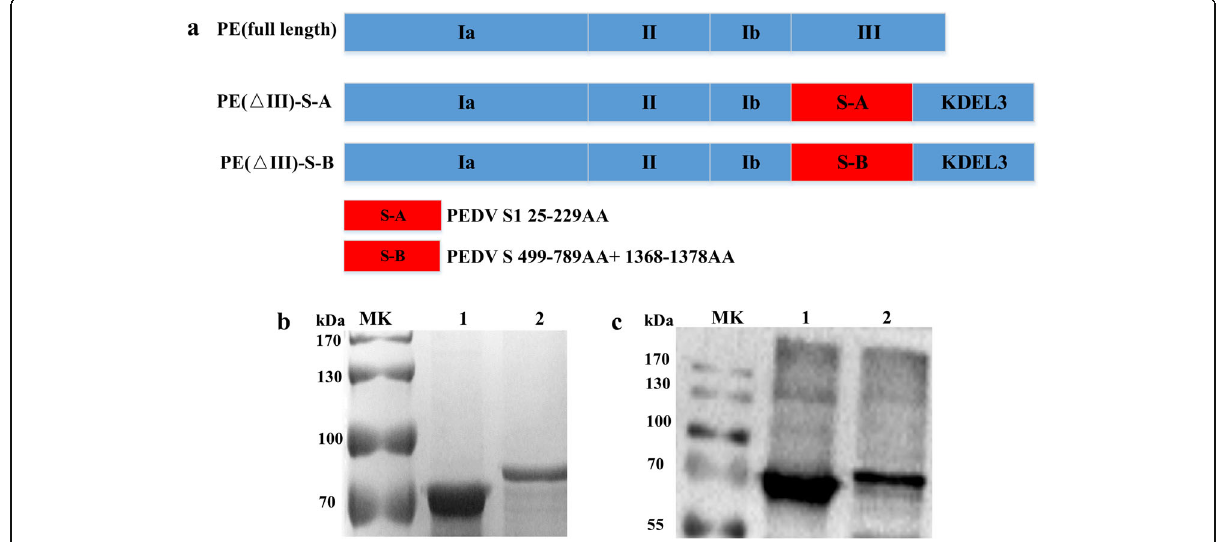
Fig. 1 Schematic and expression of the recombinant protein. a PE, full-length sequence of PE toxin contains four domains (Ia, II, Ib, III); PE ( Δ III) represents full-length sequence of a PE toxin deletant that deleted domain III. S-A, PEDV S1 aa 25-229; S-B, PEDV S aa 499-789+aa 1370-1378. b SDS-PAGE analysis of PE( Δ III)-PEDV-S-A and PE( Δ III)-PEDV-S-B proteins purified through affinity chromatography. Lane 1: PE( Δ III)-PEDV-S-A (71 kDa). Lane 2: PE( Δ III)-PEDV-S-B (80.5 kDa). c Western blot analysis of PE(III)-PEDV-S-A and PE(III)-PEDV-S-B proteins. Lane 1: PE( Δ III)-PEDV-S-A. Lane 2: PE( Δ III)-PEDV-S-B. Mouse anti-HisMAb and goat anti-mouse IgG-HRP were used as primary and secondary antibodies, respectively. PE, Pseudomonas aeruginosa exotoxin A; PEDV, porcine epidemic diarrhea